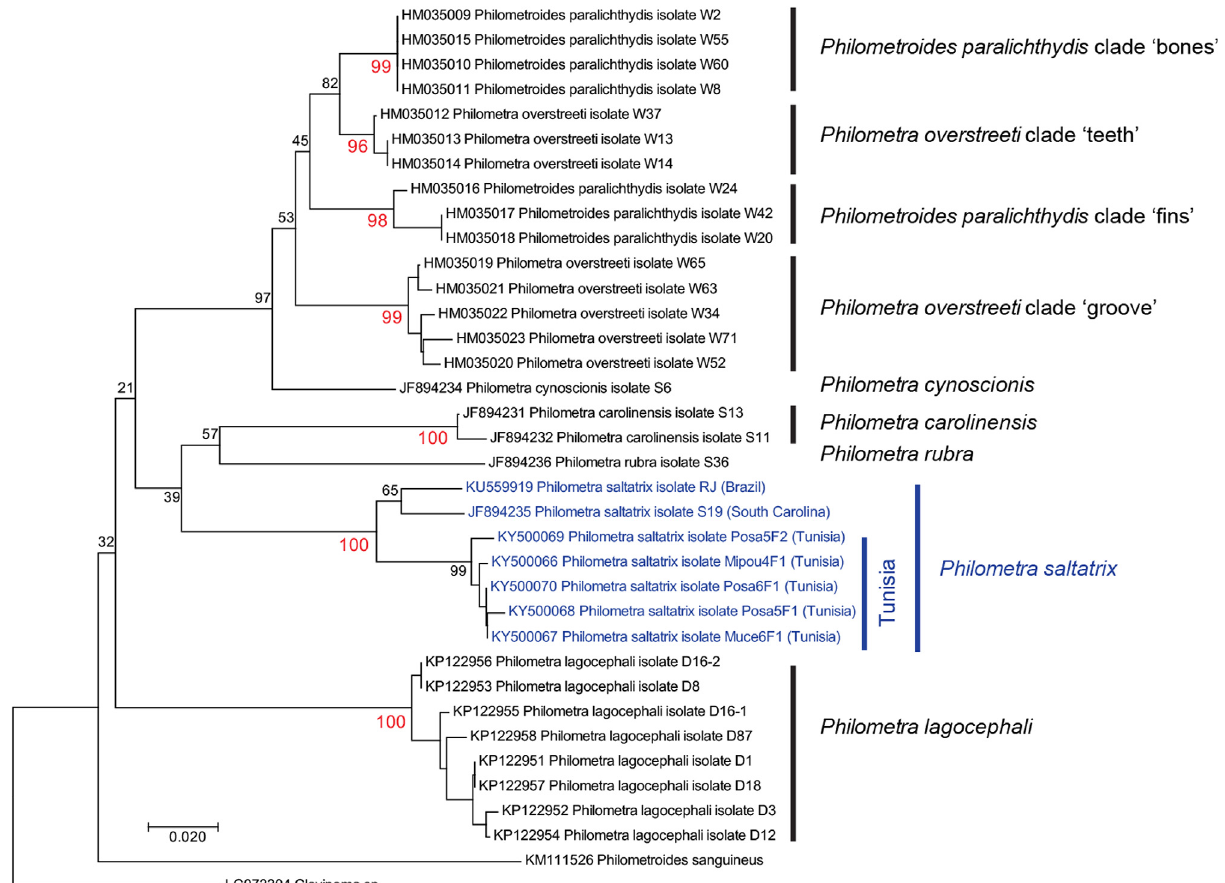
Figure 5. Tree of philometrids based on COI sequences. The evolutionary history was inferred using the Neighbour-Joining method. Bootstrap test results are shown next to the branches; red: bootstrap for clades corresponding to nominal species or clades within species (for Philometroides paralichthydis and Philometra overstreeti ). For Philometra saltatrix , all specimens are within a well-supported clade but specimens from Tunisia are separated from specimens from the Western Atlantic (Brazil and South